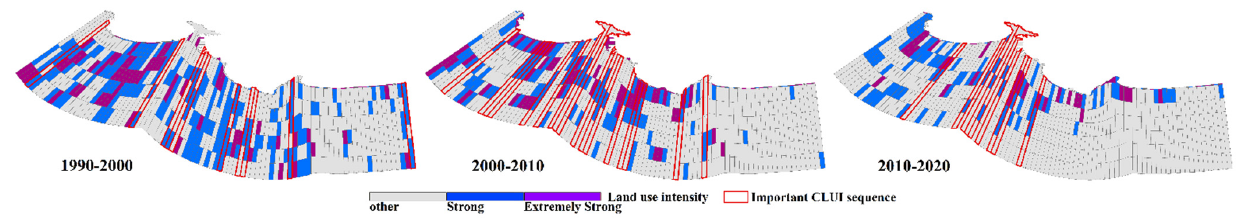
Figure 7. Distribution of the important CLDI sequences in the Yantai coastline zone.